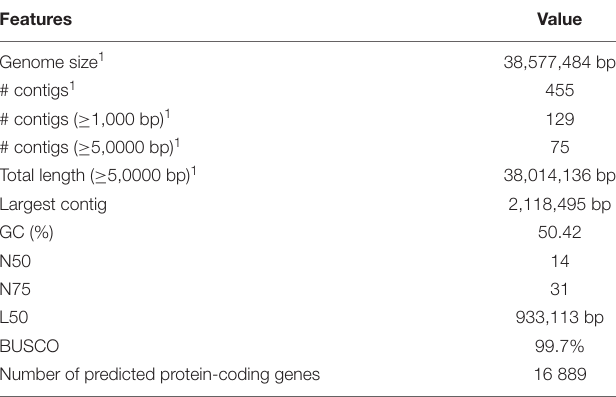
TABLE 1 | Nalanthamala psidii MA3 genome and annotation